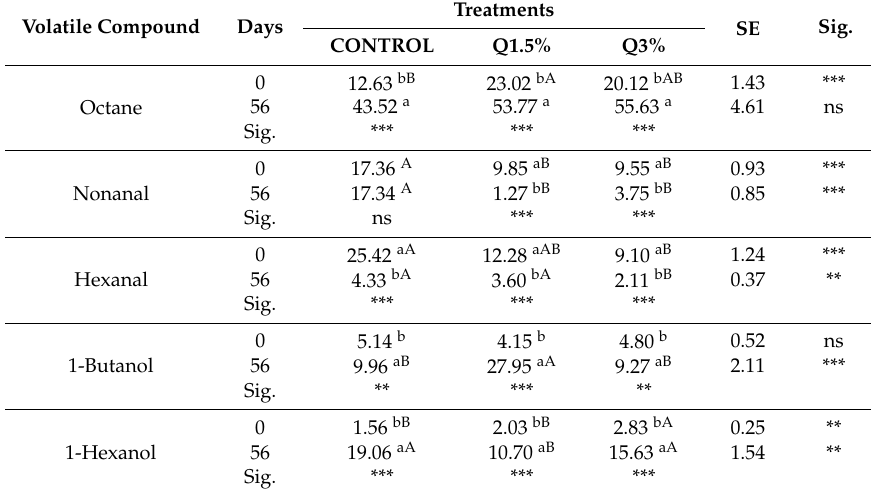
Table 4. E ff ect of the chitosan inclusion on lipid-derived volatile compounds (expressed as units of area (AU) × 10 4 / g of a sample) of low-fat cooked sausages made from turkey meat a ff ected by white striping